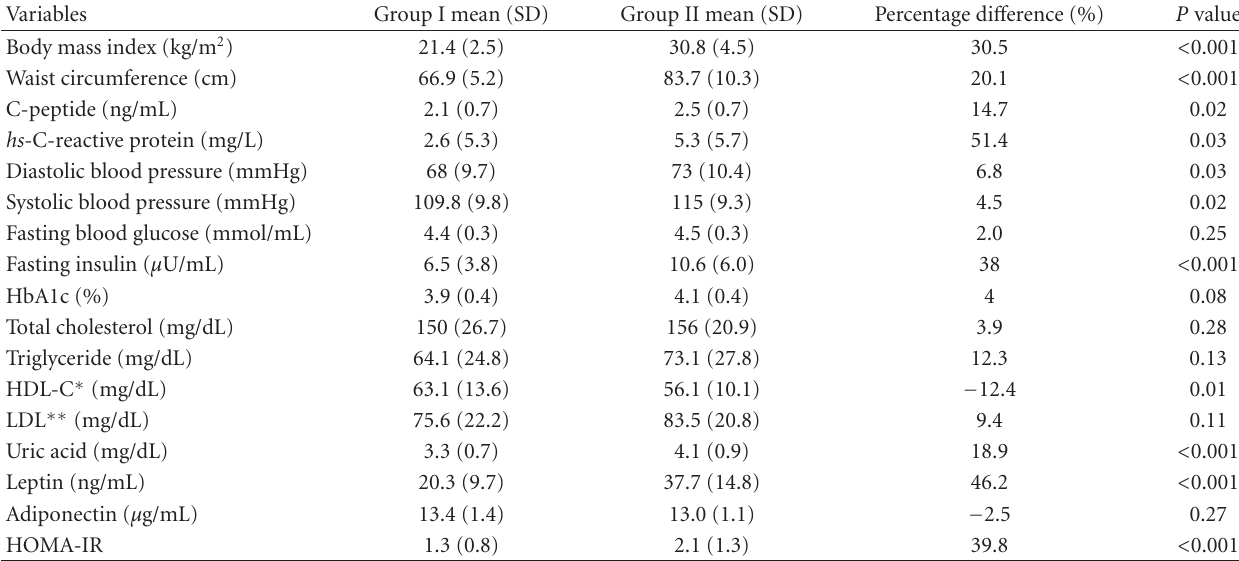
Table 1: Baseline characteristics of normal-weight (Group I ( n = 35)) versus overweight/obese females (Group II ( n = 45)).